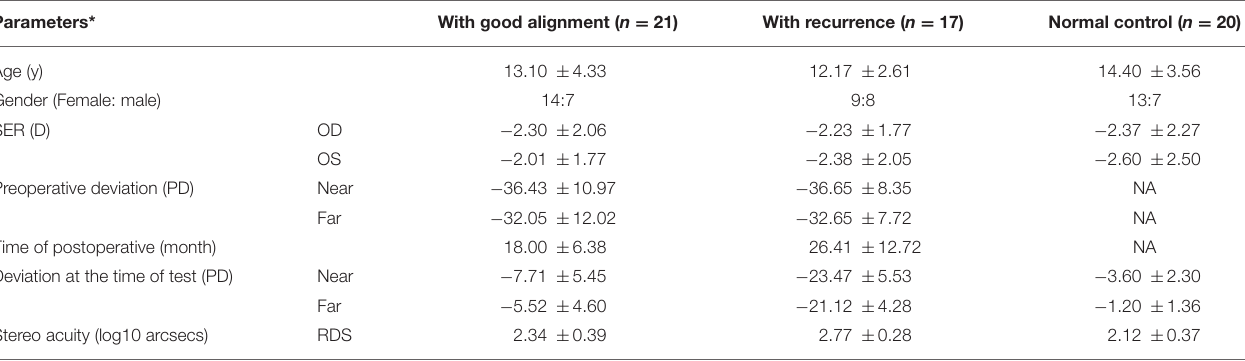
TABLE 1 | Participant demographics and clinical